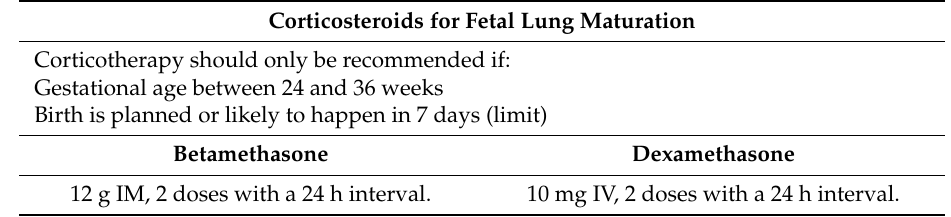
Table 6. Proposed pharmacotherapy for fetal lung